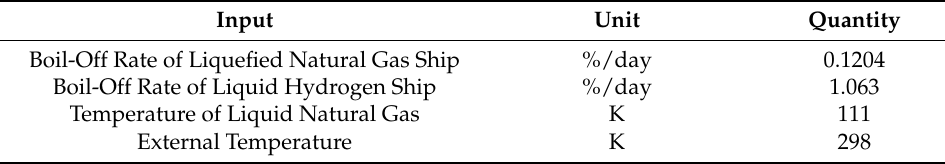
Table 6. LNG and LH2 data on BOR and operating temperature